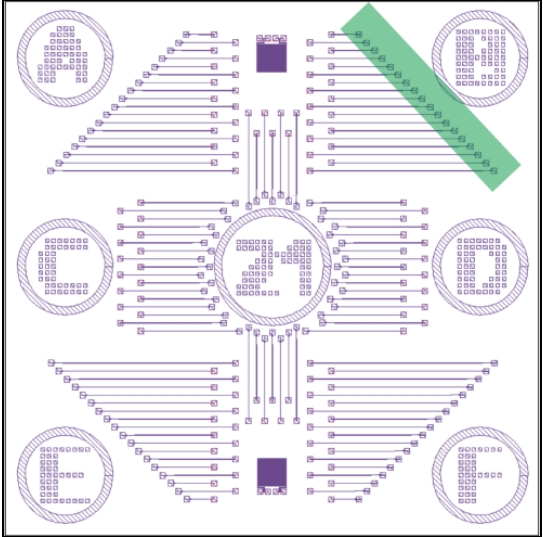
Figure 9. Illustration of graphene membrane placement on the wafer.